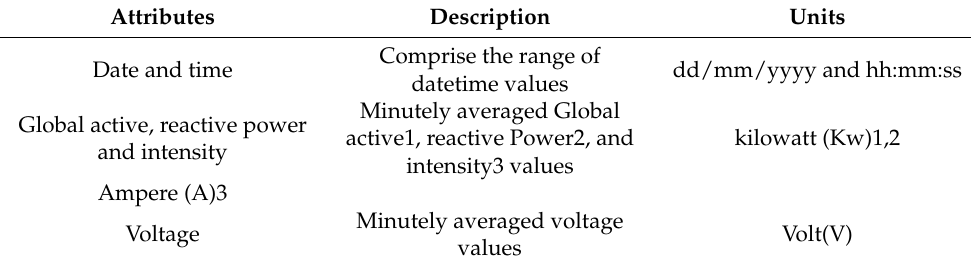
Table 2. IHEPC dataset attributes and units. Attributes Description